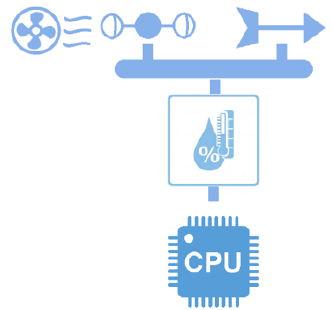
Figure 6. MEIoT weather station with exogenous disturbance input